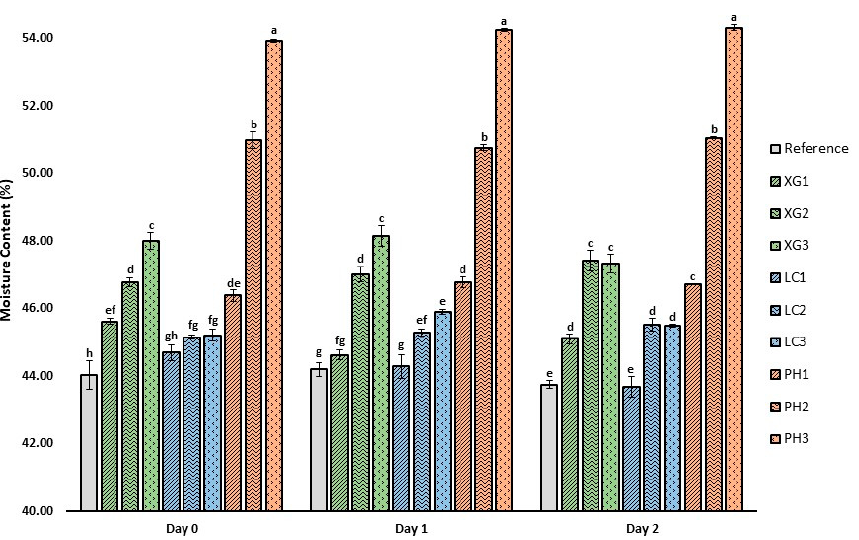
Figure 3. Moisture content of bread samples over three days of storage at room temperature (~25 °C). Error bars represent mean ± standard deviation, n = 2. Different letters represent significant difference ( p < 0.05) within the same day (i.e., Day 0, 1 or 2).